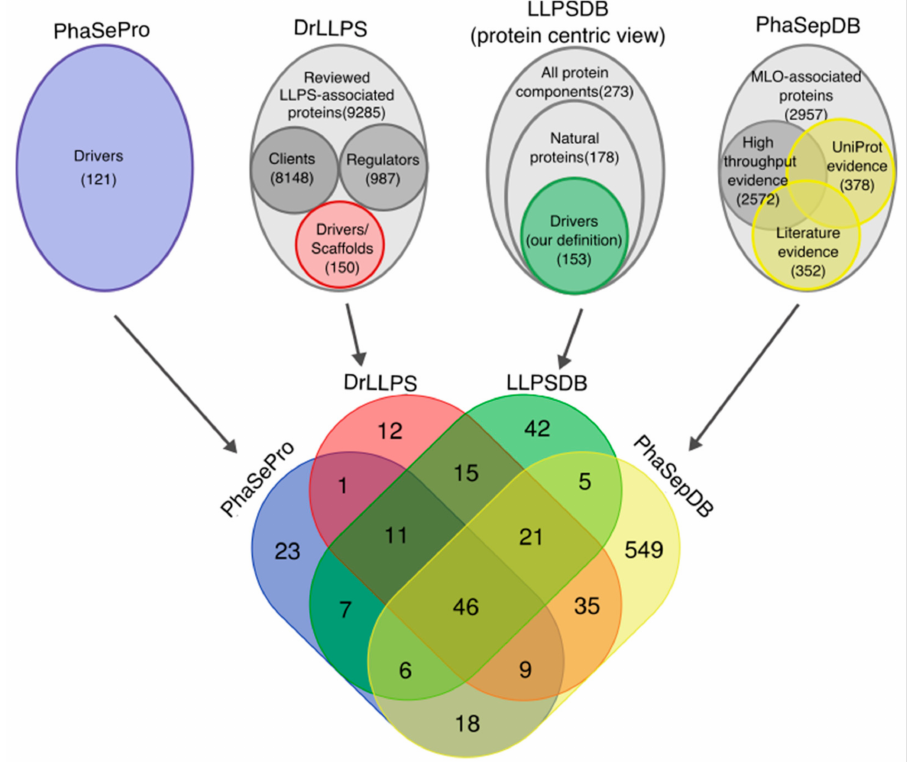
Figure 1. Content and overlap of the four liquid–liquid phase separation (LLPS) datasets. The contents of the four databases (PhaSePro, DrLLPS, LLPSDB, PhaSepDB) are represented in the upper portion, with subsets of the data used in this analysis highlighted in color, whereas the rest of their data are depicted in different shades of gray. The total number of proteins as well as the number of proteins in the different subsets are indicated. In the Venn diagram at the bottom, the overlap of the colored subsets of the four LLPS databases is